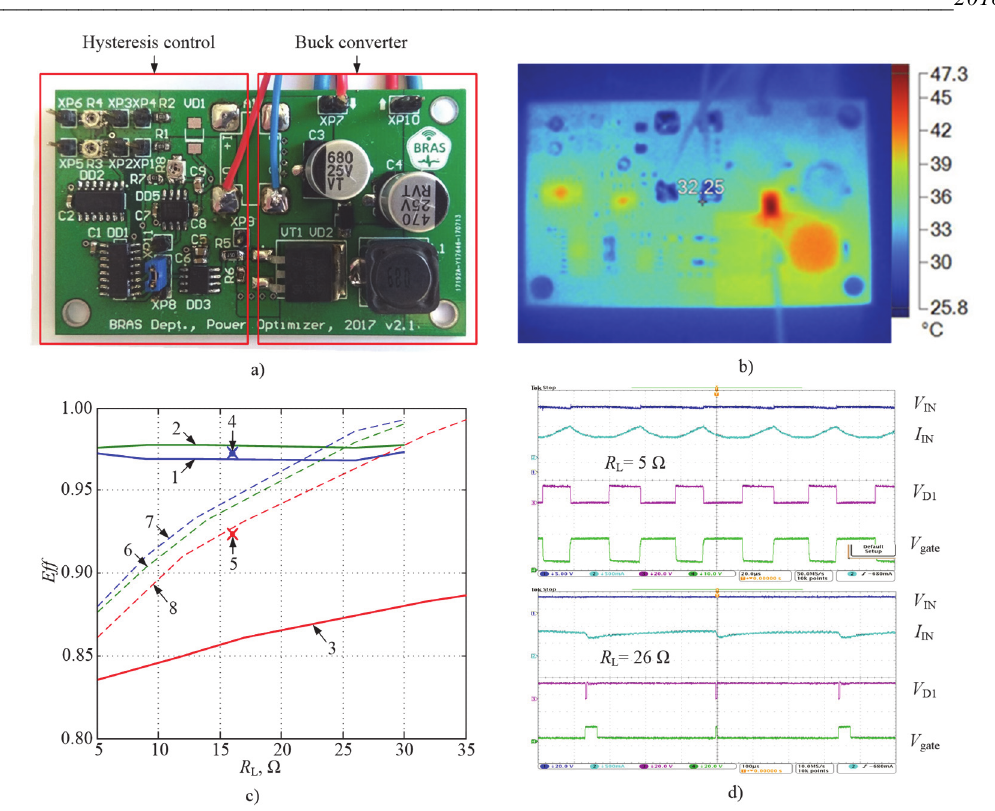
Fig. 8. Experimental prototype of power optimizer (a), thermal image for S = 1000 W/m 2 , R L = 5 Ω, T = 25 °C (b), efficiency plots for V mdl = 18.5 V, V TL = 16.5 V, V TH = 18.7 V, where 1–3 – experimental efficiency of MPP tracking, 4–5 – calculations of MPP tracking, 6–8 – experimental efficiency of buck converter for cases: 1, 4, 6 – T = 25 °C, 2,7 – T = 35 °C, 3, 5, 8 – T = 50 °C (c), experimental time diagram for R L = 5 Ω and R L = 26 Ω